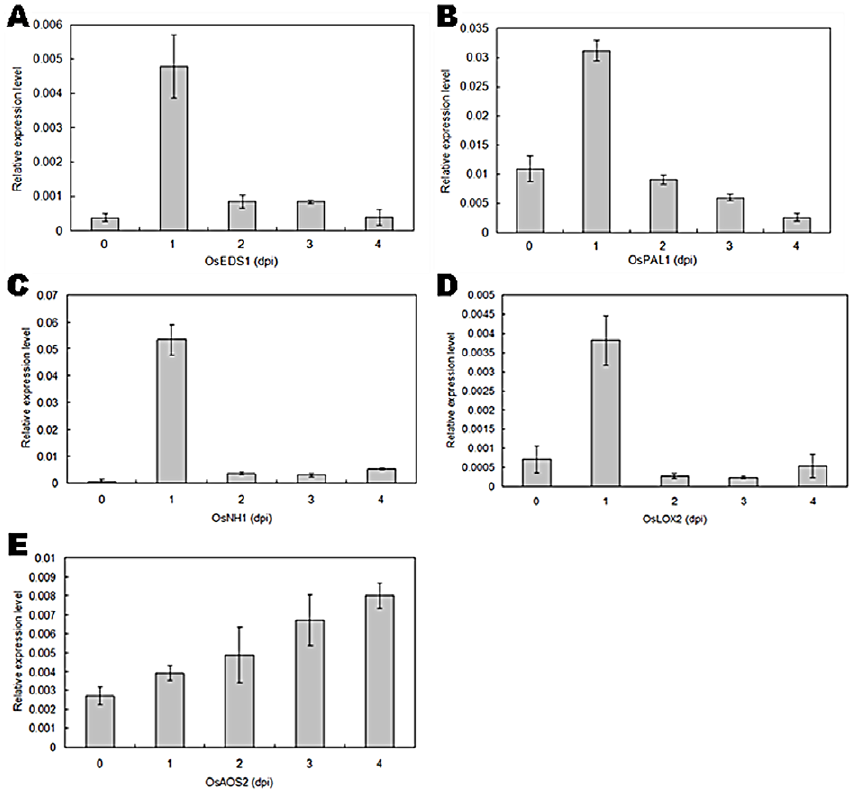
Figure 9. Certain marker genes of the defense signaling pathway are involved in the effects of MoHrip1 on rice. A . OsEDS1 , B . OsPAL1 , C . OsNH1 , D . OsLOX2 , E . OsAOS2 . Marker genes for the SA-dependent defense pathway ( OsEDS1 , OsPAL1 and OsNH1 ) were all significantly induced by MoHrip1 on the second day after treatment, and the same expression pattern was found for the JA/Et pathway gene OsLOX2 , but strong induction was not observed for OsAOS2 (another JA/Et signaling pathway marker gene). Dpi: days post-inoculation. Error bars represent 6 SD of the mean. Essentially identical results were obtained in three independent experiments.